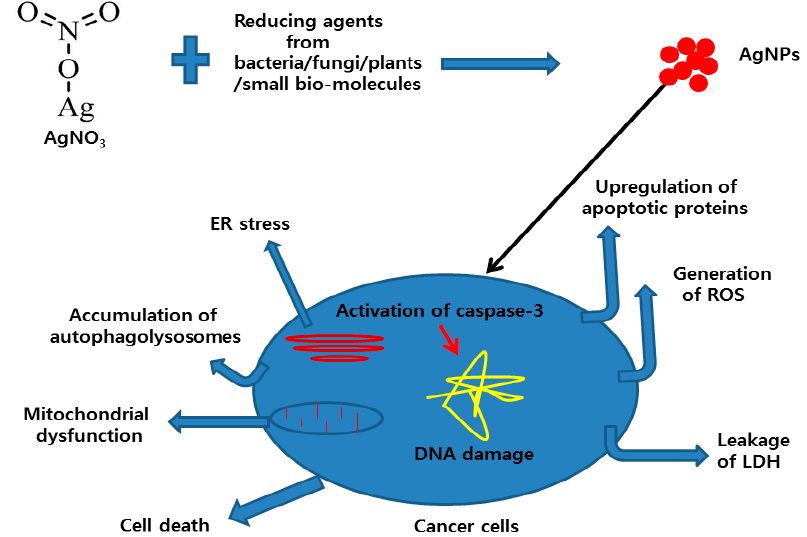
Figure 10. The possible mechanisms of AgNP-induced cytotoxicity in cancer cell lines. Endoplasmic reticulum stress(ER), lactate dehydrogenase (LDH), reactive oxygen species (ROS).